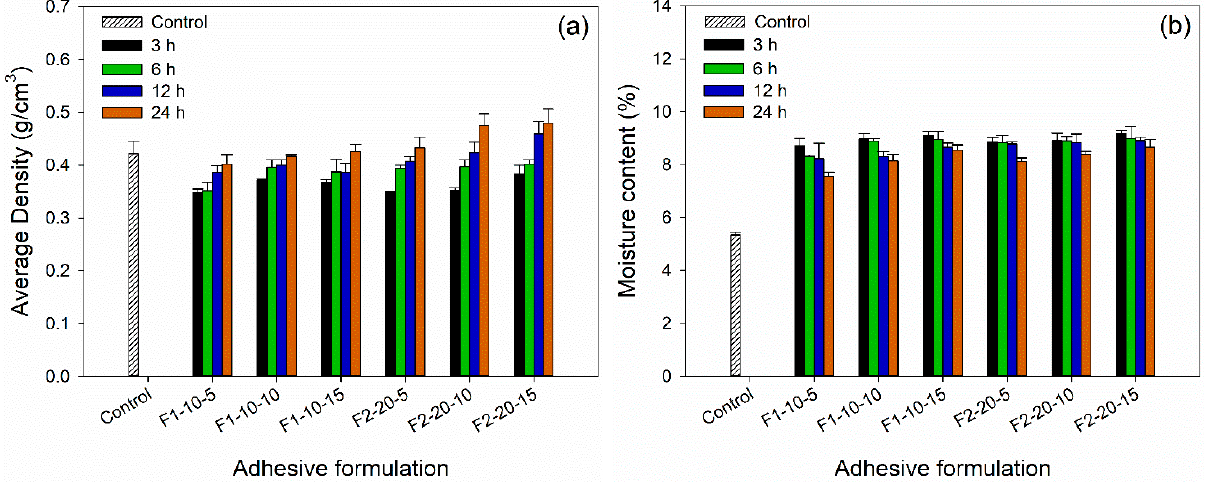
Figure 5. Physical properties of plywood bonded with PVOH–tannin–hexamine-based adhesives. ( a ) Average density, ( b ) moisture content.